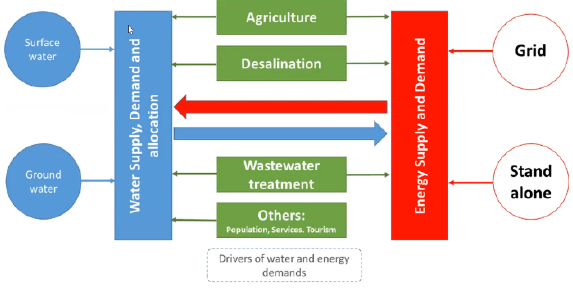
Figure 3 The Nexus model for Morocco (Source: 2 nd Water-Energy- Food Nexus Webinar series –